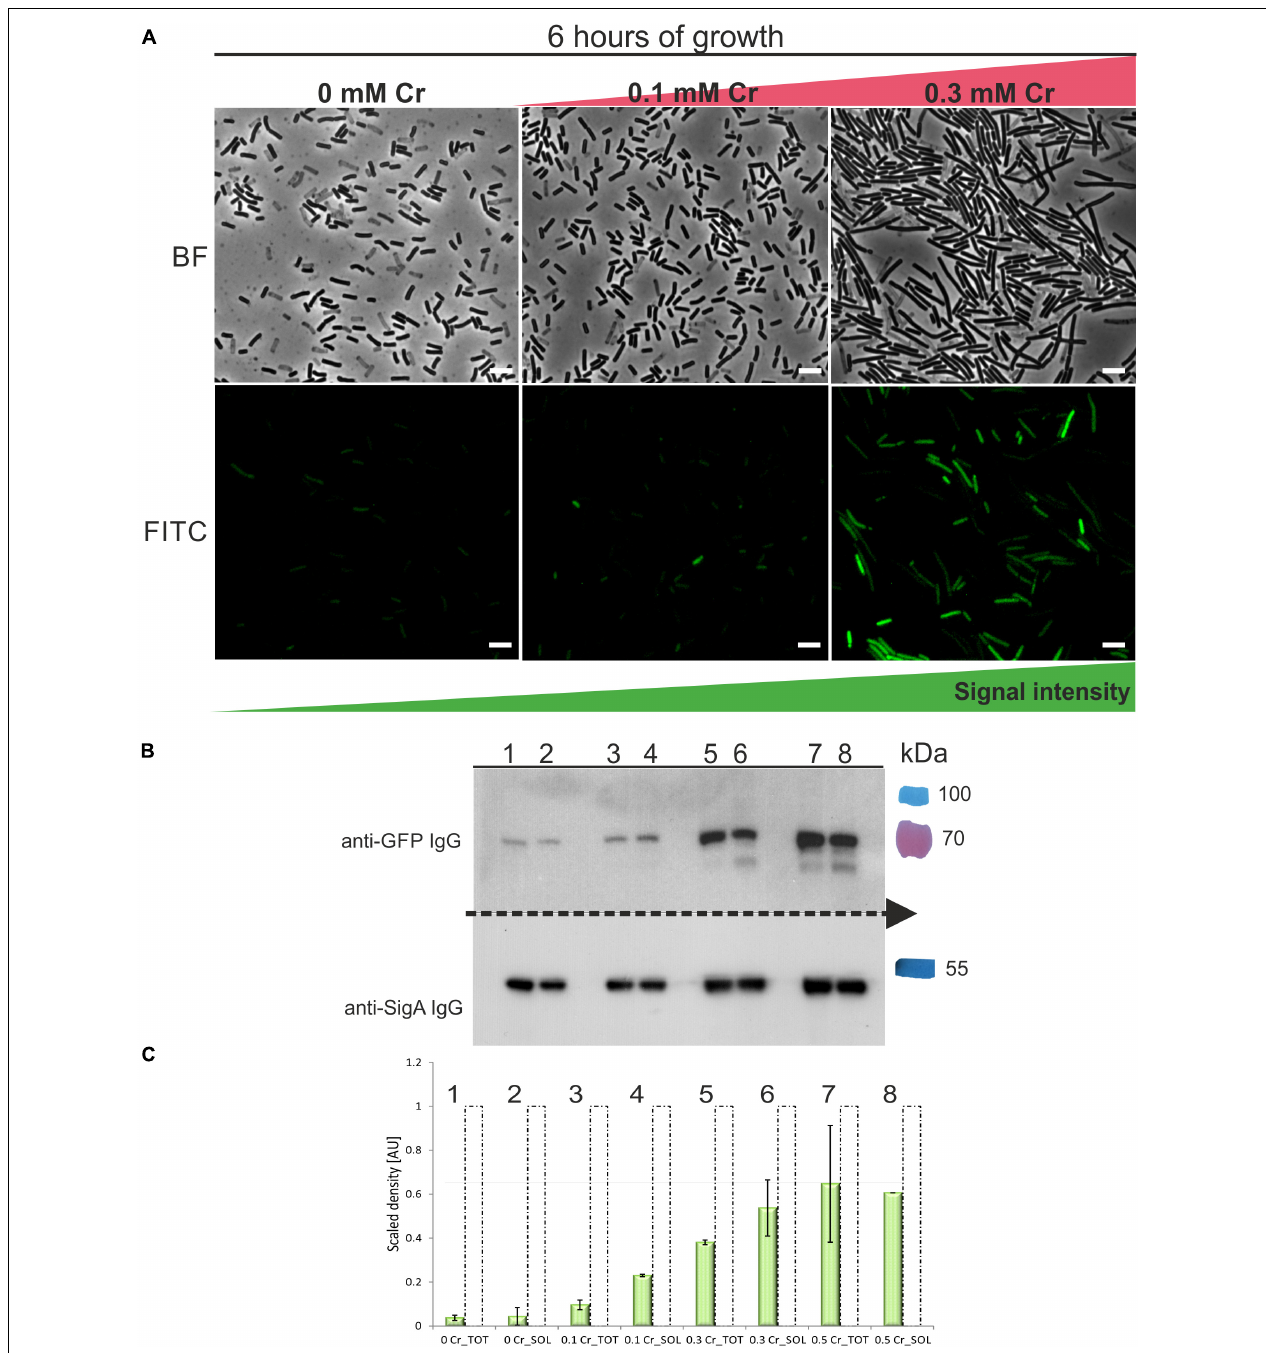
FIGURE 6 | Expression of GFP-ChrA in B. subtilis strain exposed to different Cr(VI) stress. (A) Fluorescence microscopy of GFP-ChrA in cells of B. subtilis subjected to Cr stress. Upper panel shows bright-field images, bottom panel shows fluorescence images of the strain P chrA - gfp-chrA . GFP-ChrA fusion is expressed under the control of its chrA promoter in B. subtilis PY79. With increasing concentrations of Cr(VI), the number of cells expressing GFP-ChrA increases as does the length of cells and the intensity of the GFP signal. The scale bars represent 5 µ m. (B) Western blot analysis of P chrA - gfp - chrA lysates using anti-GFP and anti-Sig70 antibodies. The Western blot membrane was cut in half. Each half was incubated with the appropriate IgG to be able to detect both GFP-ChrA and SigA simultaneously, for each sample. Lanes 1–2 represent samples incubated without Cr, lanes 3–4 are samples incubated with 0.1 mM Cr(VI), lanes 5–6 are samples incubated with 0.3 mM Cr(VI) and lanes 7–8 are samples incubated with 0.5 mM Cr(VI). The last color lane represents the protein molecular weight standards in kDa (PageRuler TM Plus Prestained). (C) Quantification of the GFP-ChrA signal in total and soluble fractions of samples subjected to varying Cr stress. The signals were quantified by the ImageJ software. The data are labeled by numbers of the corresponding lanes on the Western blot. Dashed unfilled columns represent the relative amount of SigA normalized to 1. Green-filled columns represent the relative amount of GFP-ChrA normalized to the amount of SigA.